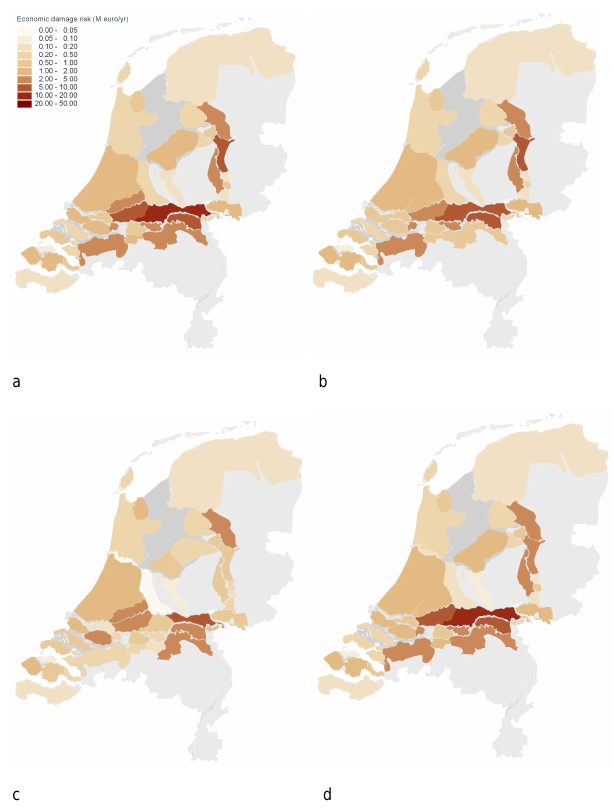
Fig. 6. Economic damage risk (Meuroyr − 1 ) in each dike-ring area in 2050 if (a) the current policy were continued, and in various Figure 6. Economic damage risk (M euro/ yr) in each dike-ring area in 2050 when (a) the 6 strategic alternatives: (b) “protect”, (c) “accommodate” and (d) “re- current policy is continued, and in various strategic alternatives: (b) ‘protect’, (c) ‘accomodate’ 7 treat”. and (d) ‘retreat’. 8